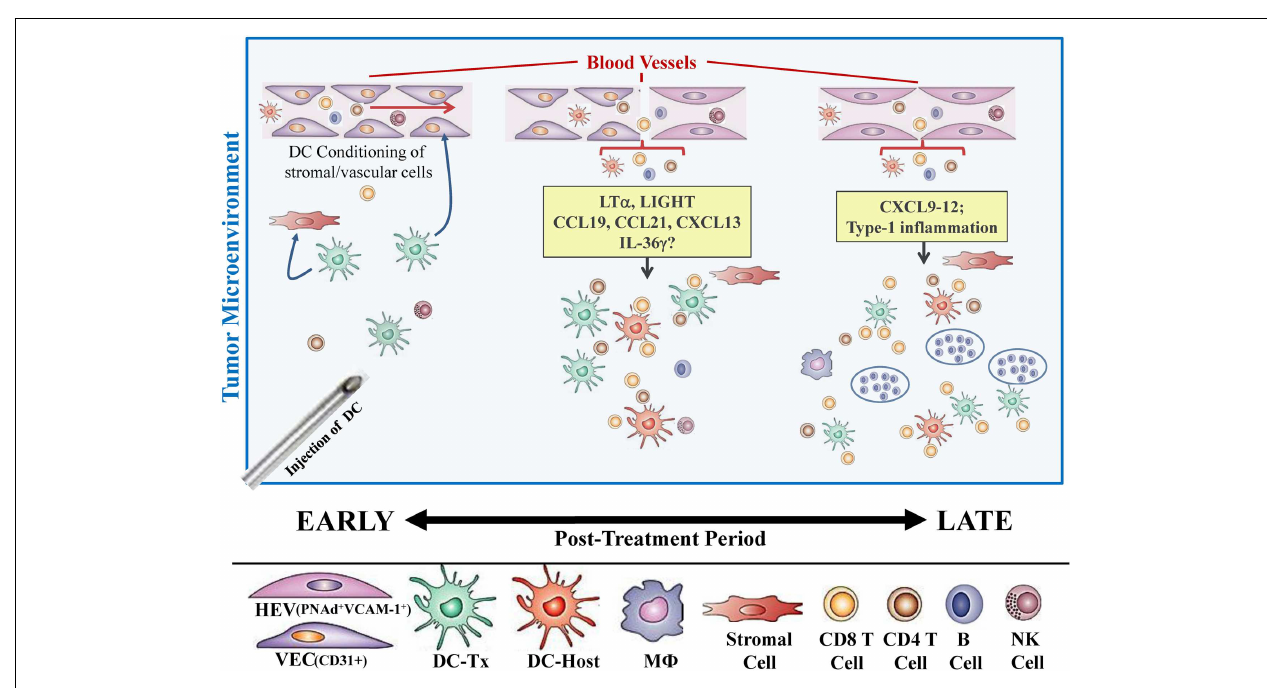
recruitment of naïveT cells into theTME since these structures do not become discernible until later time points [i.e., day 5; Figure 1 and (5)]. B220 + B cells recruited into theTME as a consequence of treatment with DC.Tbet cells are not organized into follicle-like structures during the day 2–5 time period, but may become organized in this manner at even later time points (i.e., ≥ day 9 post-therapy), based on previous reports employing alternate immunotherapeutic interventions, such as ch14.18-LT α (8).While therapeutic benefits in our model were largelyT cell-dependent and detectable prior to the establishment of formalTLO structures (based on the development of B cell follicles), the presence of “mature”TLO in human tumors has been associated with better clinical